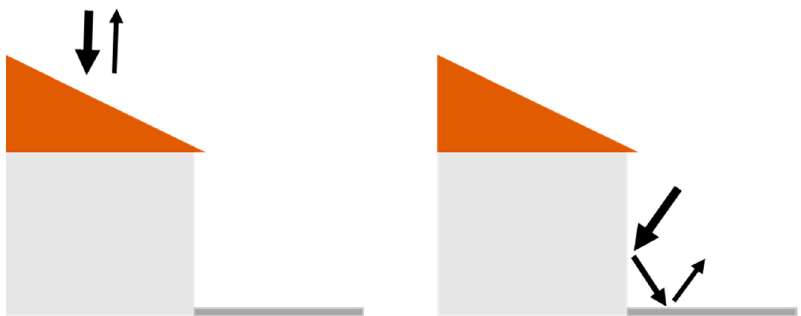
Figure 1. Schematic of irradiance balance of 1D model for rooftops (left) and 2D model for facades